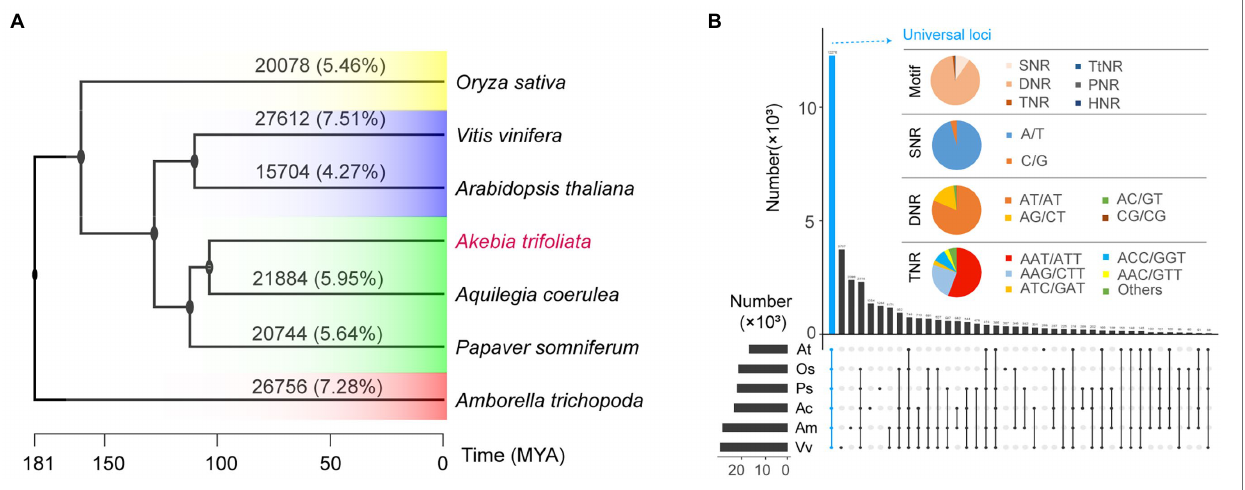
FIGURE 4 | Comparative analysis of SSR loci in seven species. (A) Sequence similarity of SSR loci in Akebia trifoliata matched with the other six species; the phylogenetic tree was downloaded from the TimeTree database. (B) Repeat unit types of homologous SSRs among different species and motifs of the universal loci of seven